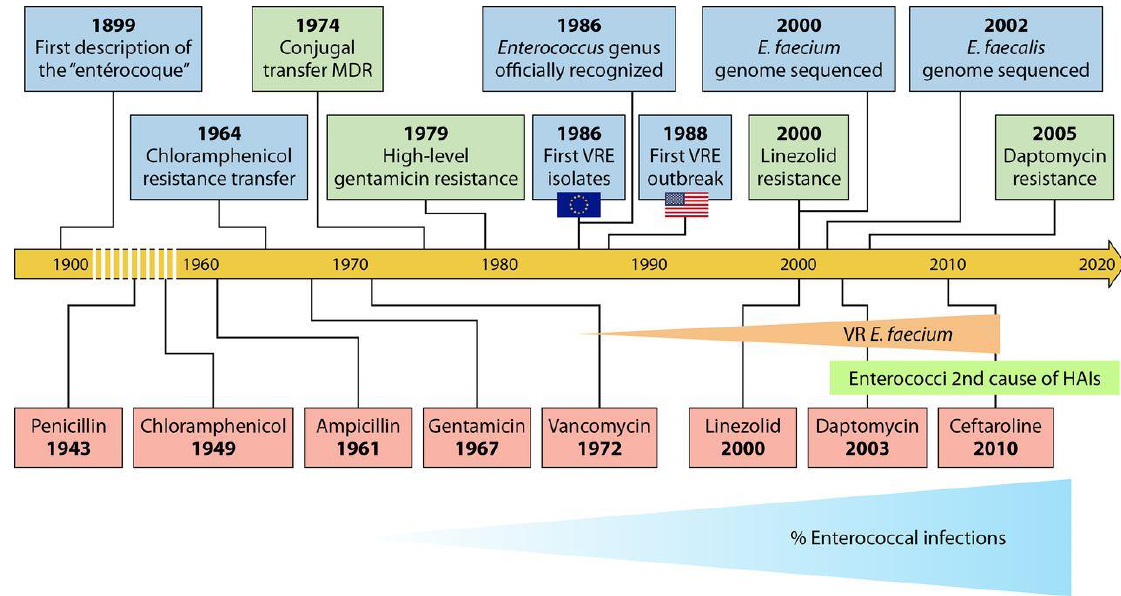
Figure 2. History of enterococci as human pathogens, with emphasis on emergence of antibiotic resistance in the genus. HAIs: hospital acquired infections. Reprinted with permission from García-Solache et al. [219]. (License No. 5016471445387).